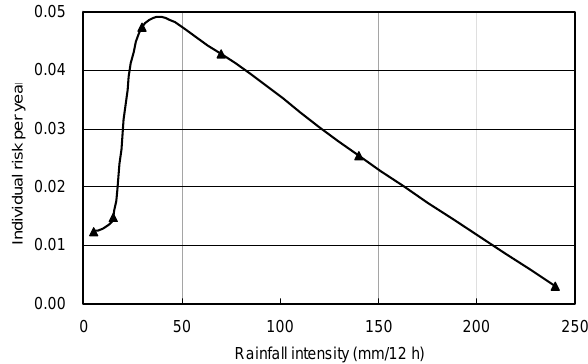
Fig. 16. Individual risk of the loose deposits between K1 and K18 shortly after the earthquake.